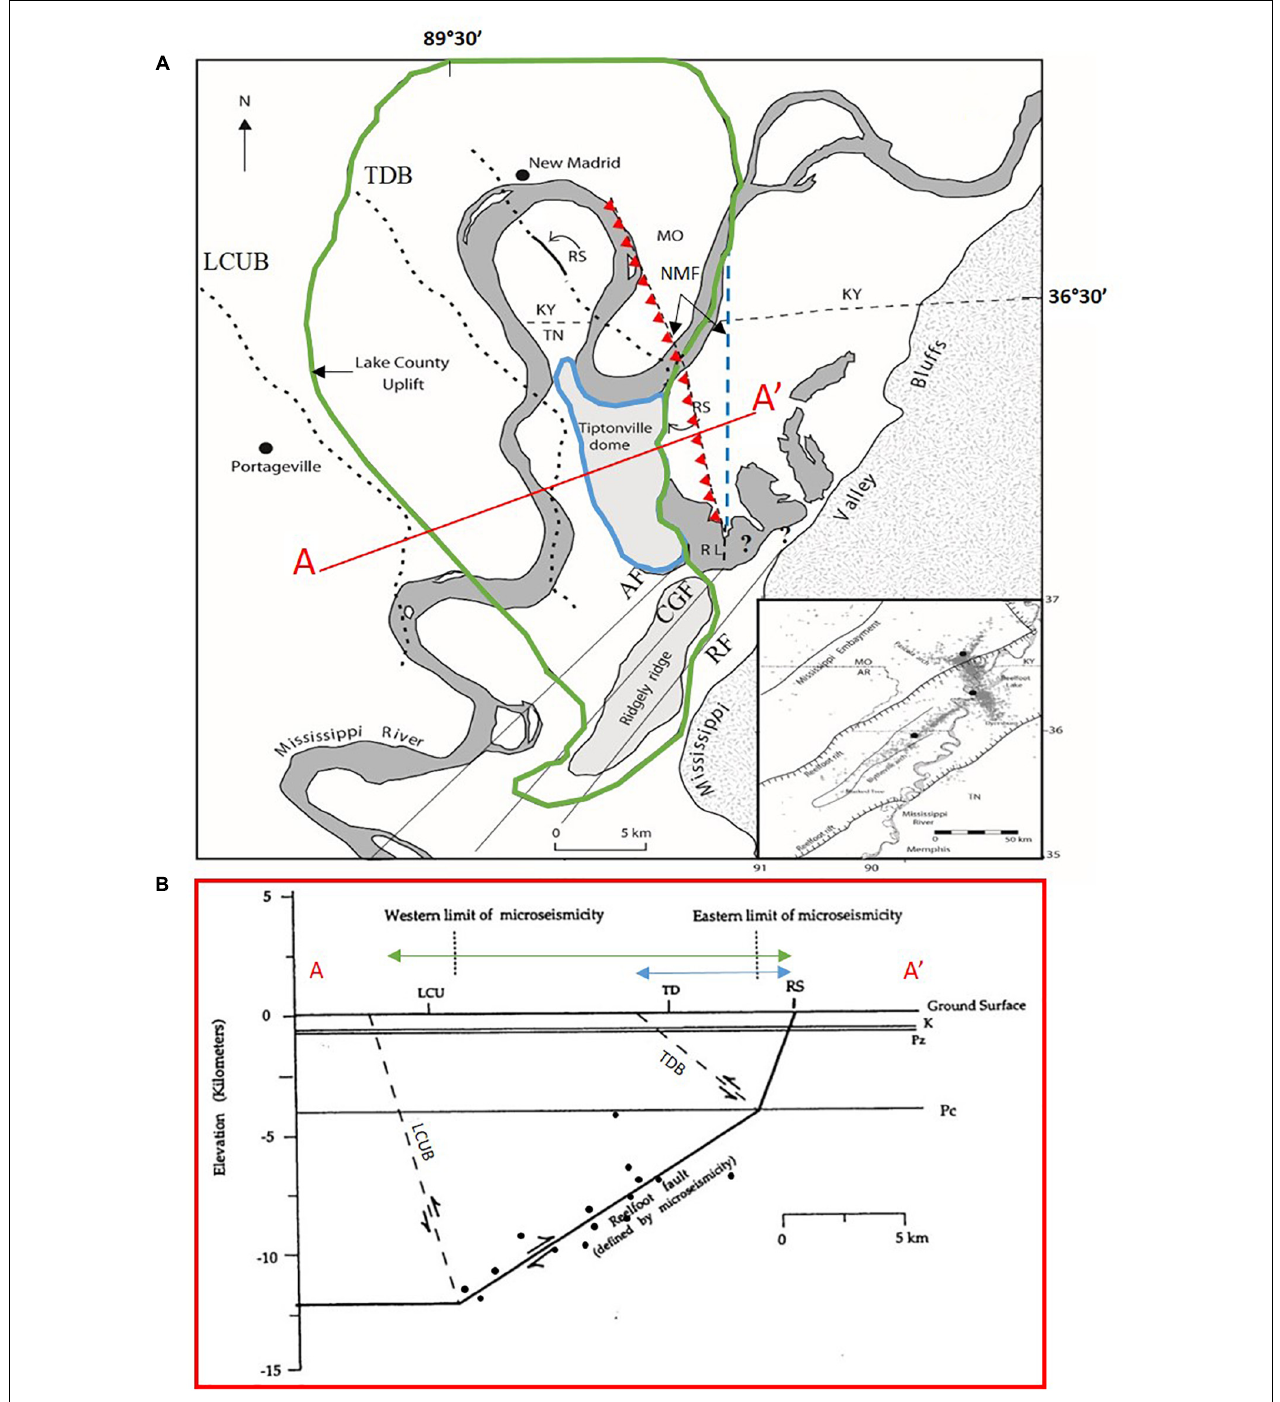
FIGURE 2 | (A) Map of the major faults and structures of Lake County area. This includes the Lake County uplift (green perimeter) and its proposed west-bounding back thrust (dashed, LCUB), the northwest-trending Tiptonville dome (blue perimeter) and its proposed west-bounding back thrust (dashed, TDB), and the east-facing Reelfoot scarp monocline (RS) along the Reelfoot reverse fault, which bounds the Tiptonville dome and locally Reelfoot Lake (RL). Also shown is the southwest-trending Ridgely ridge bounded on the west by the Cottonwood Grove fault (CGF) and on the east by the Ridgely fault (RF). Axial fault (AF) is shown to the west of Ridgely ridge. New Markham fault (NMF) interpreted by Guo et al. (2014) (red barbed dashed-line) and original interpretation by Odum et al. (1994, 1998) and Van Arsdale et al. (1998) (blue dashed-line). Small inset map shows NMSZ (Johnston, 1996) [modified from Purser and Van Arsdale (1998)]. (B) Geologic cross-section of Lake County illustrating the deep structure and the 32 ◦ dipping fault plane within the Precambrian rock along which most earthquakes occur. The NMF is not shown in this cross-section. Earthquake hypocenters (dots along Reelfoot fault) from Figure 2J of Mueller and Pujol (2001).